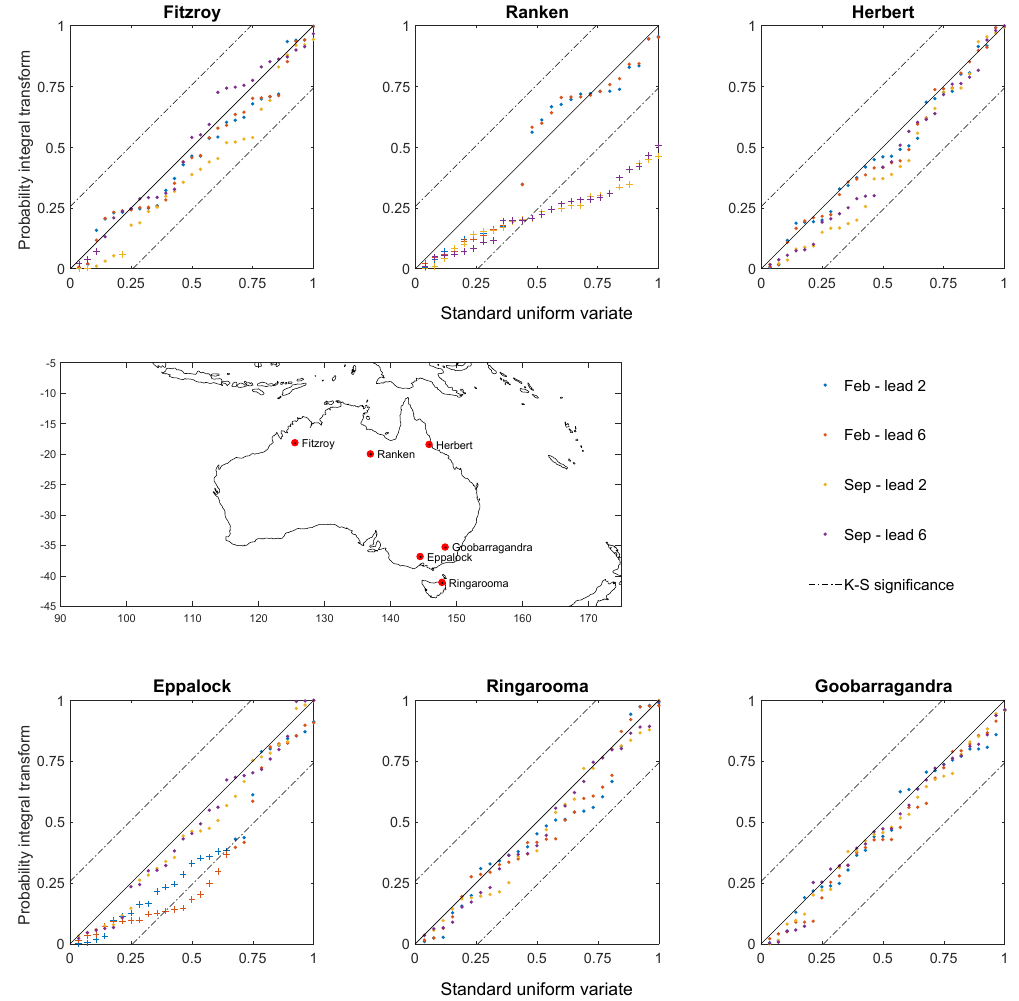
Figure 5. PIT plots for selected months and lead times for FoGSS forecasts (base case). Points are PIT values; crosses are pseudo-PIT values. Centre map gives catchment locations. Dashed lines give Kolmogorov–Smirnoff significance tests at